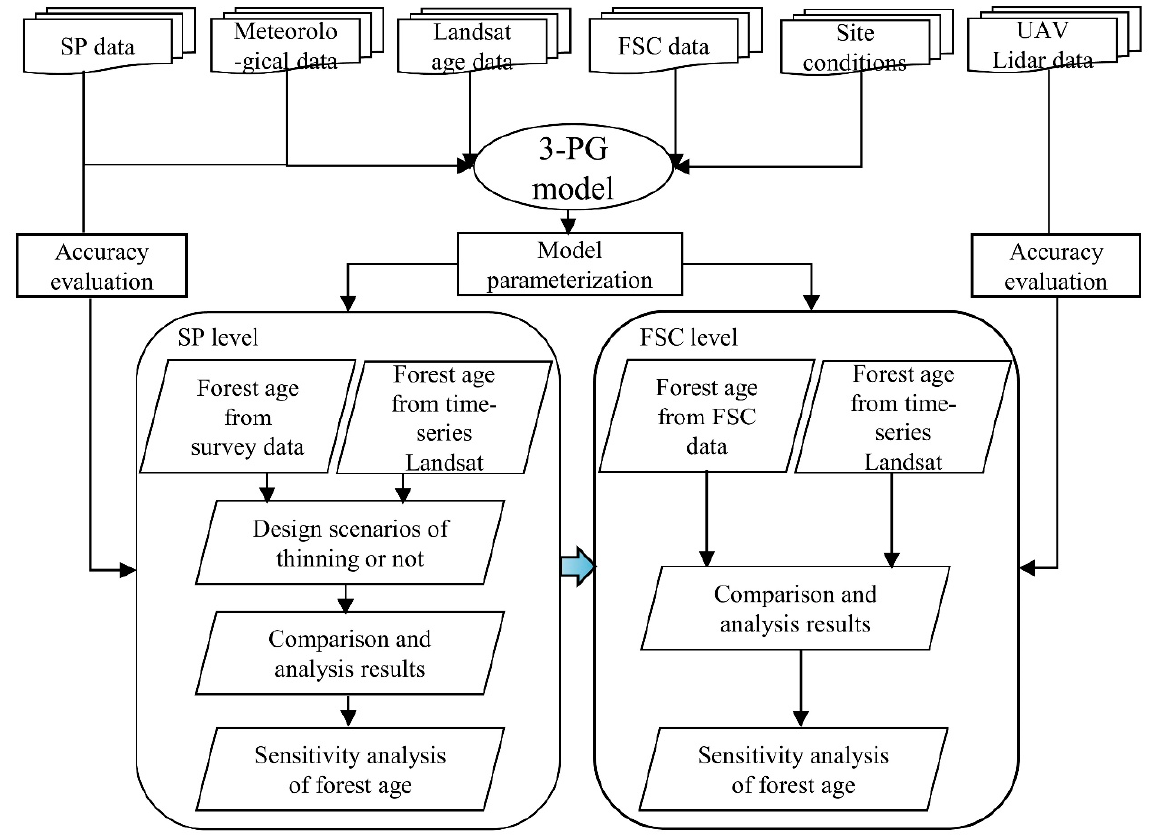
Figure 3. The overall work flow chart of the article. Simulation Scheme Based on the SP